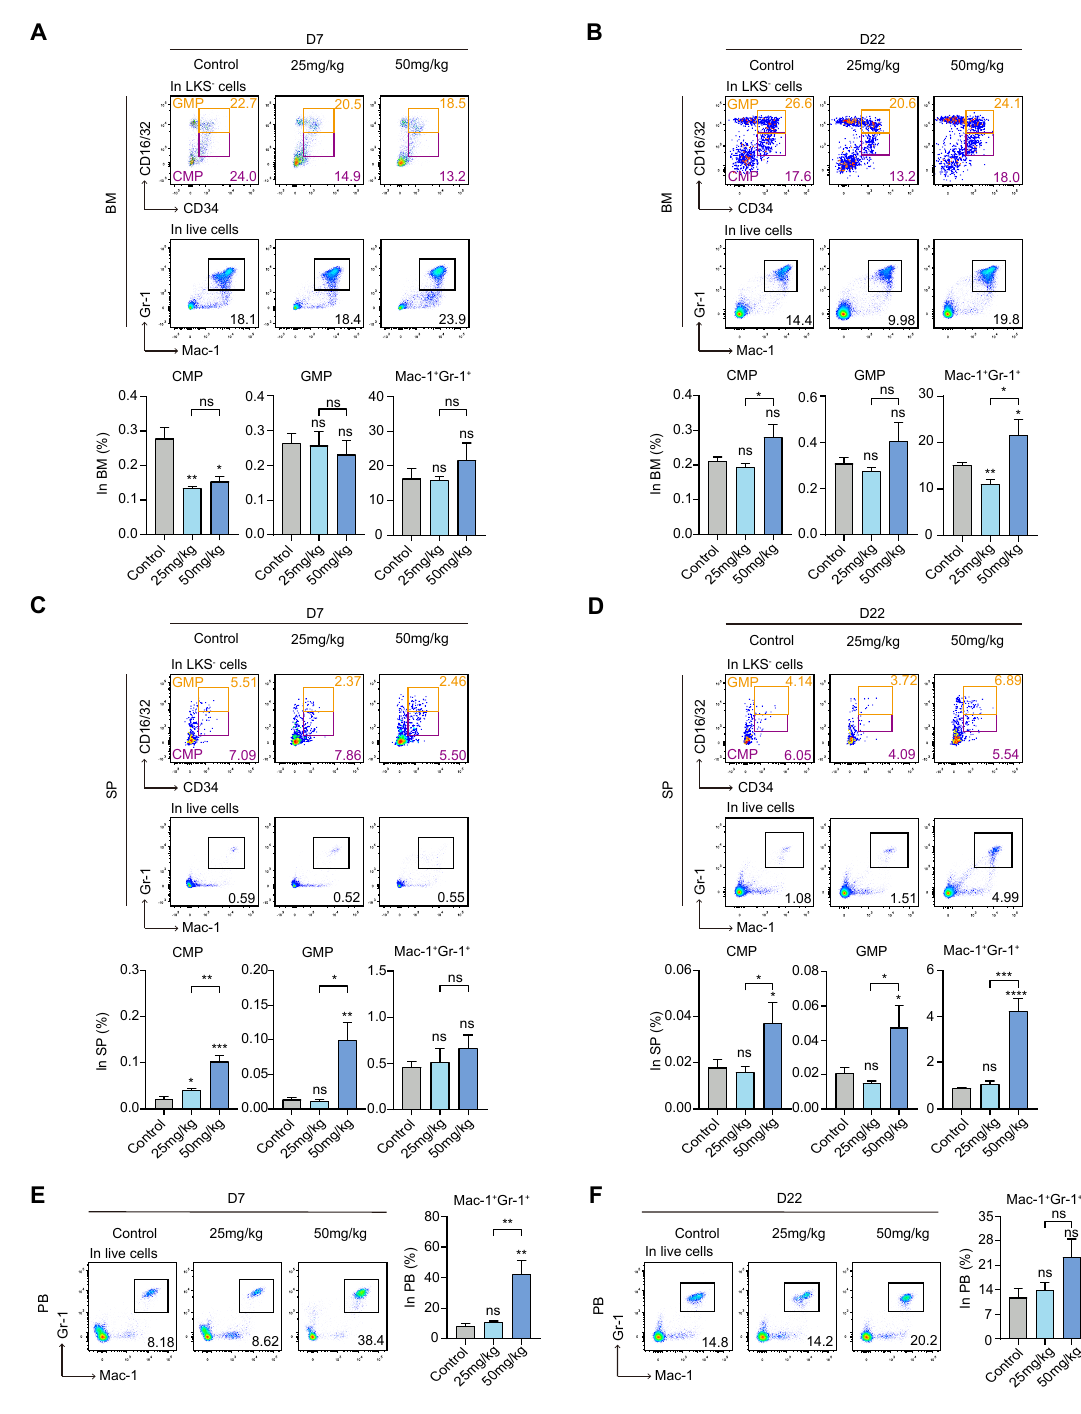
Figure 3. Effect of S63845 treatment on myeloid differentiation in CB6F1 mice. ( A ) Representative FACS profiles (upper panel) and percentages (lower panel) of CMP, GMP, and Mac-1 + Gr-1 +